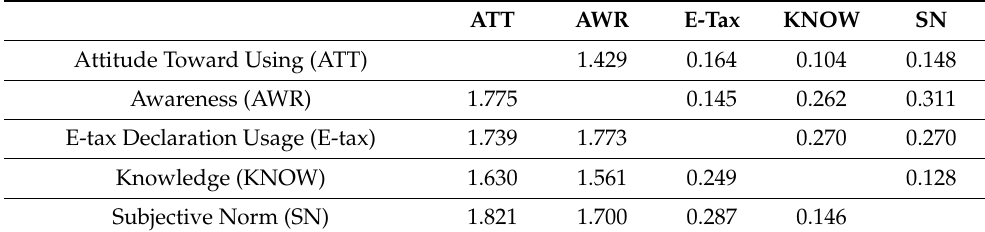
Table 3. Common Method Variance/Bias via full Collinearity Analysis.